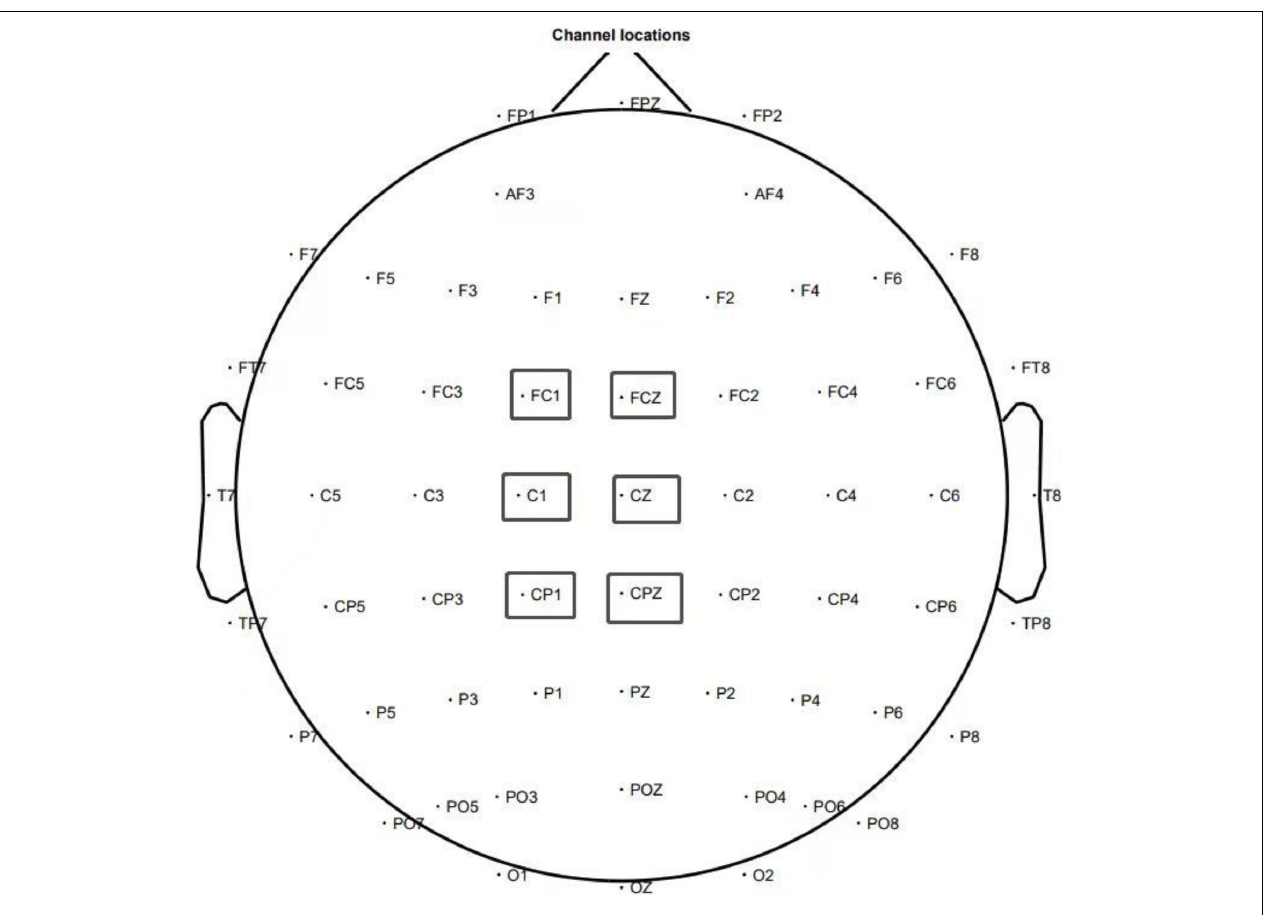
FIGURE 2 | Overall distribution of 64 electrodes and selection of analytical electrodes.